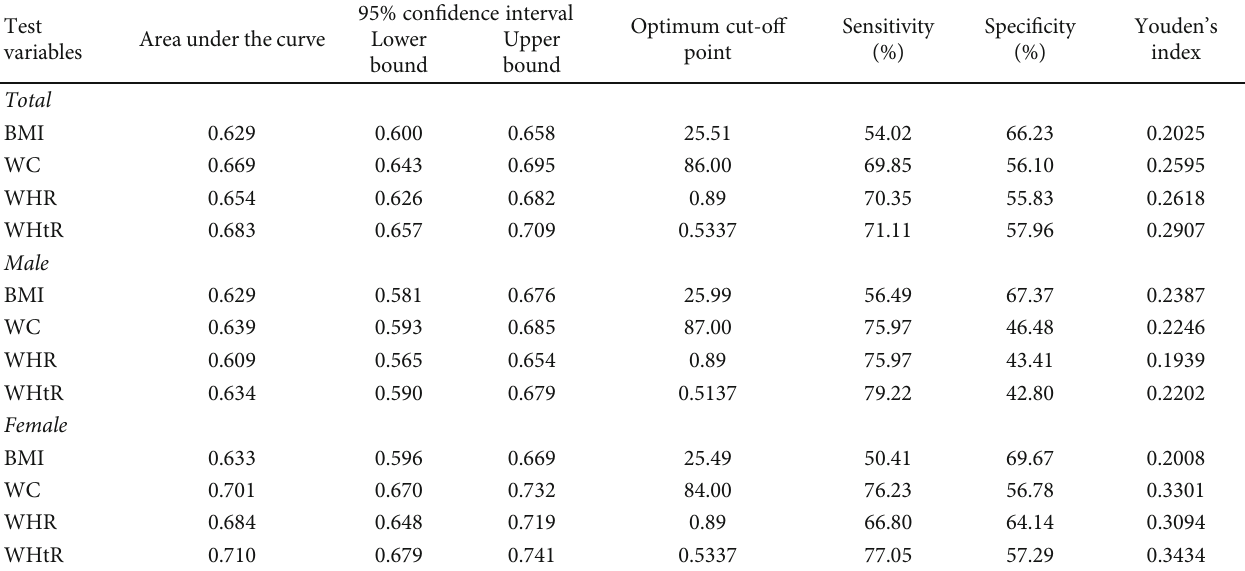
Table 3: The area under the curve and the optimum cut-o ff points of the body fat-measuring indices for